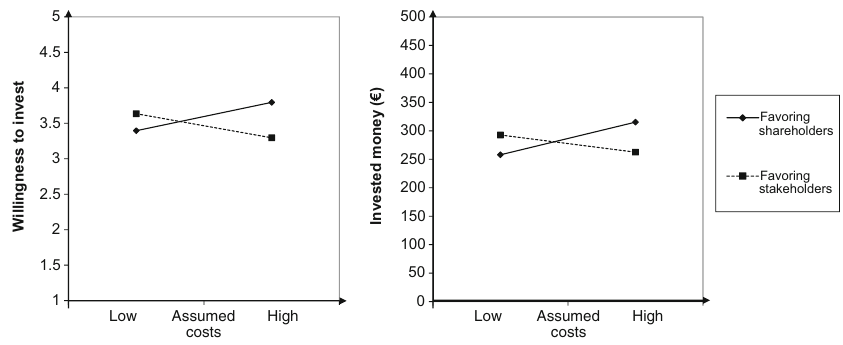
11.522.533.544.5